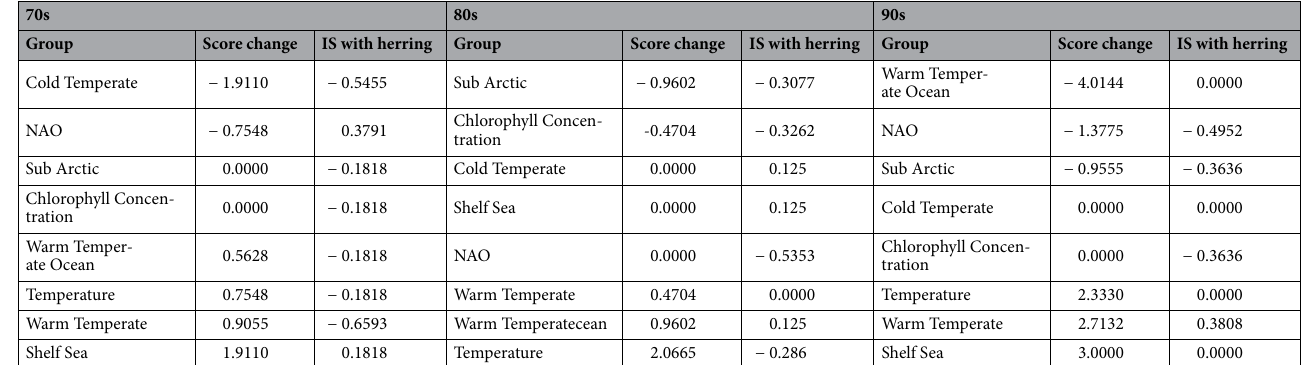
Table 3. The naïve Bayes classifiers for the time-lagged herring catch data with each group. The more negative the change in score, the better the network fit to the data, which reflects an underlying dependency between the herring and the group.